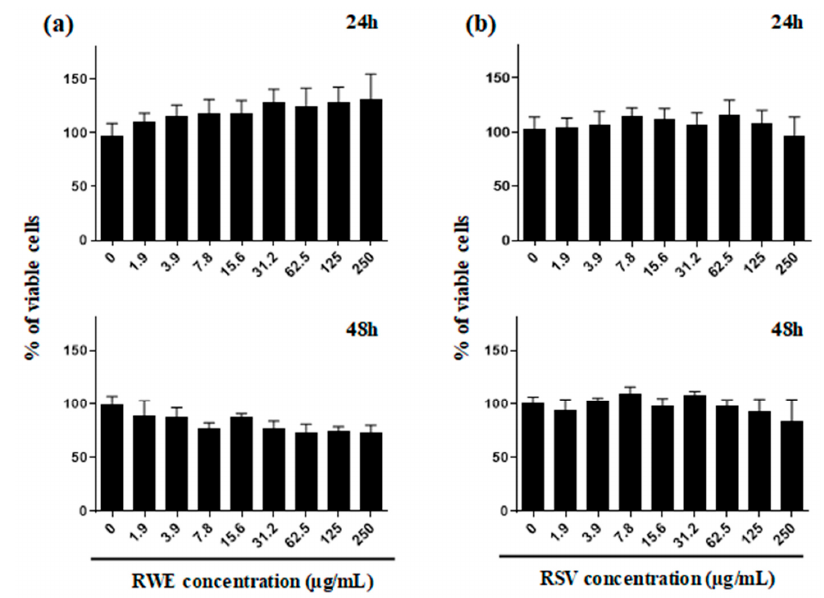
Figure 4. Safety assessment of red wine extract (RWE) and RSV on human retinal cell line ARPE-19. Crystal violet staining was performed in order to analyzed the cell viability of ARPE-19 after 24, 48 and 72 h of the ( a ) RWE treatment (starting concentration up to 250 µ g / mL, 1:2 serial dilutions) and ( b ) RSV (starting concentration up to 250 µ g / mL, 1:2 serial dilutions). Data are expressed as mean percentages ± s.d. of three independent